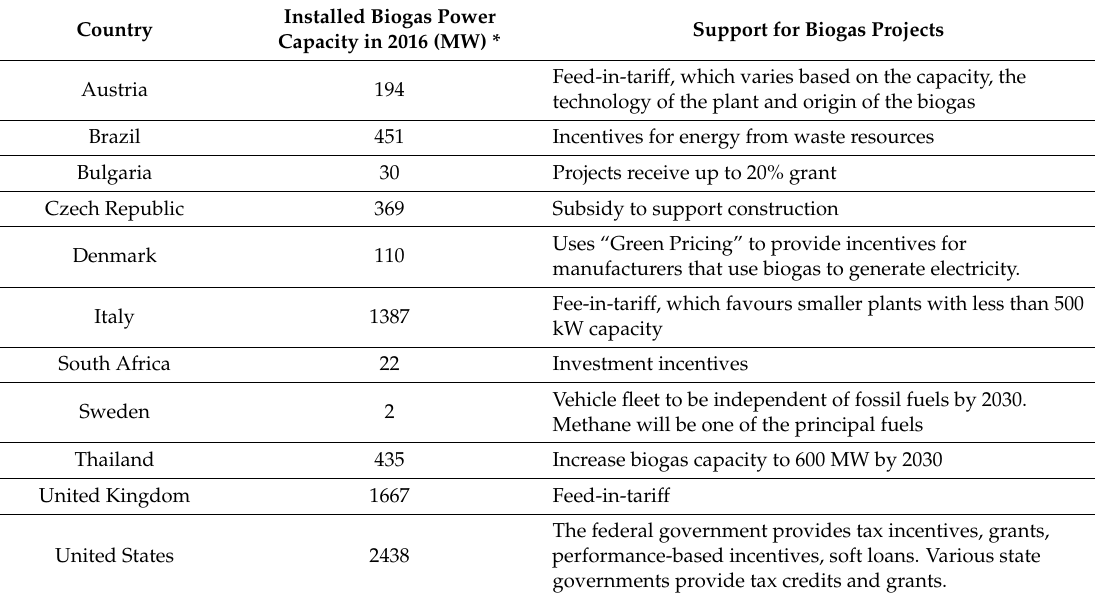
Table 2. Summary of other countries’ capacities and support